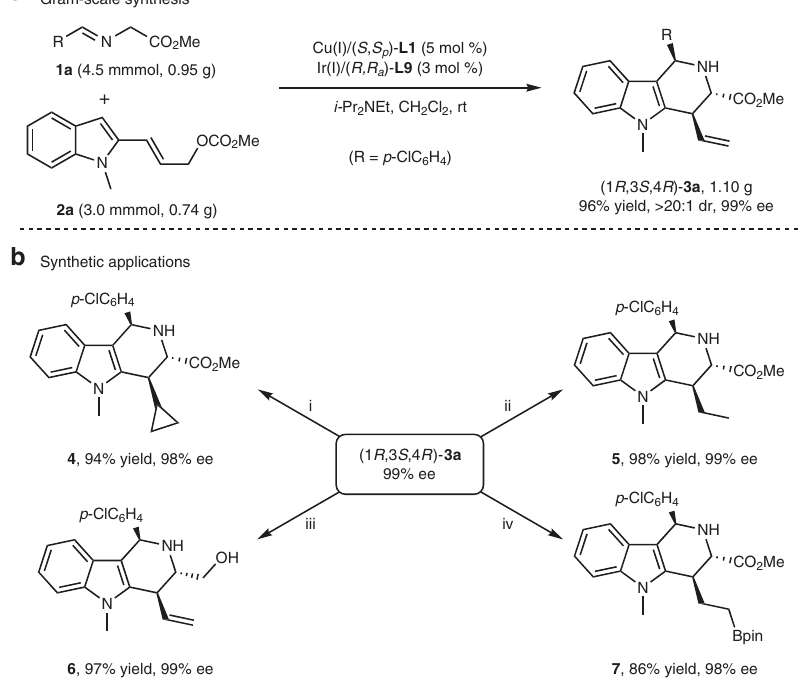
Fig. 3 Gram-scale synthesis and derivatization of the cycloadduct 3a . a Gram-scale reaction. b Synthetic applications. i: Pd(OAc) 2 (1 mol %), CH 2 N 2 , Et 2 O, − 20 °C; ii: Pd/C (catal.), H 2 (1 atm), MeOH, room temperature; iii: DIBAL-H, THF, CH 2 Cl 2 ,